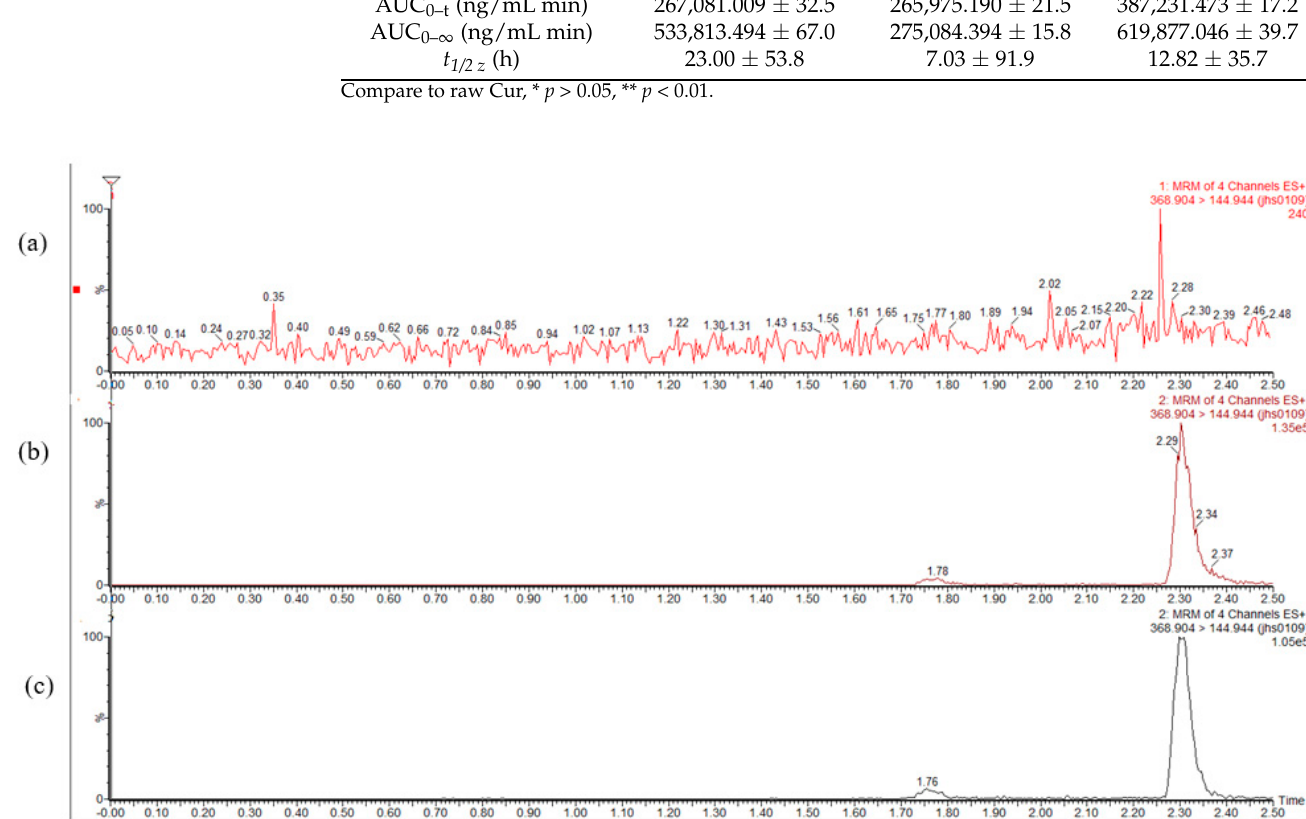
Figure 13. Mass spectrograms of Cur in blank plasma ( a ), blank plasma added reference ( b ) and plasma after administration ( c ).